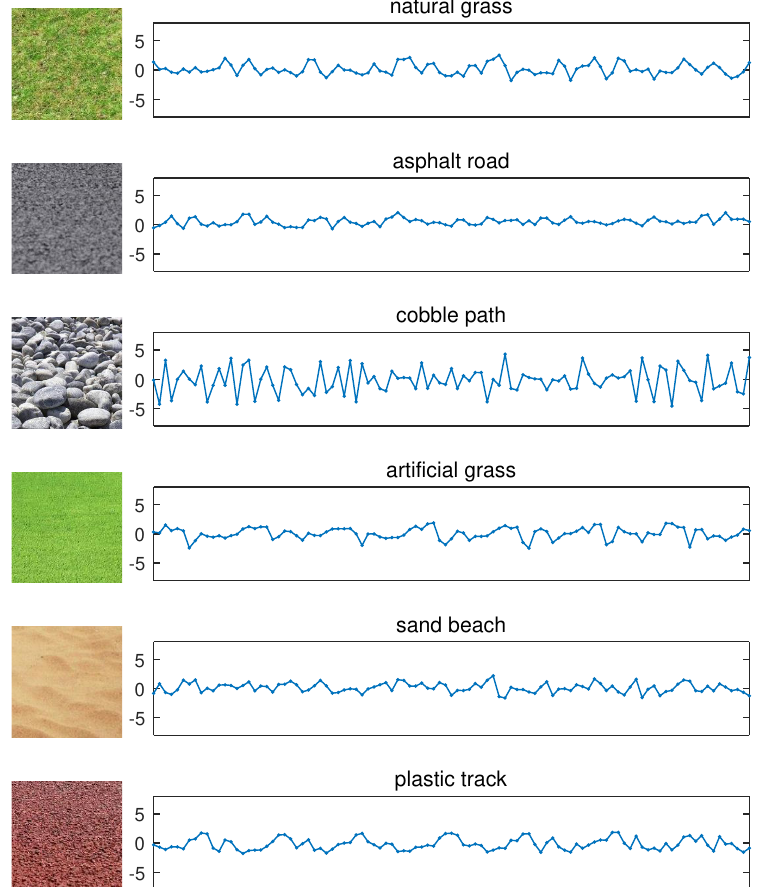
Figure 3. Photos of the traversed terrains and the corresponding segments of vibration time series. From top to bottom, the experimental terrains are: natural grass, asphalt road, cobble path, artificial grass, sand beach, plastic track, respectively. They are abbreviated as NG, AR, CP, AG, SB, and PT, respectively. The Y axis represents acceleration (m/s 2